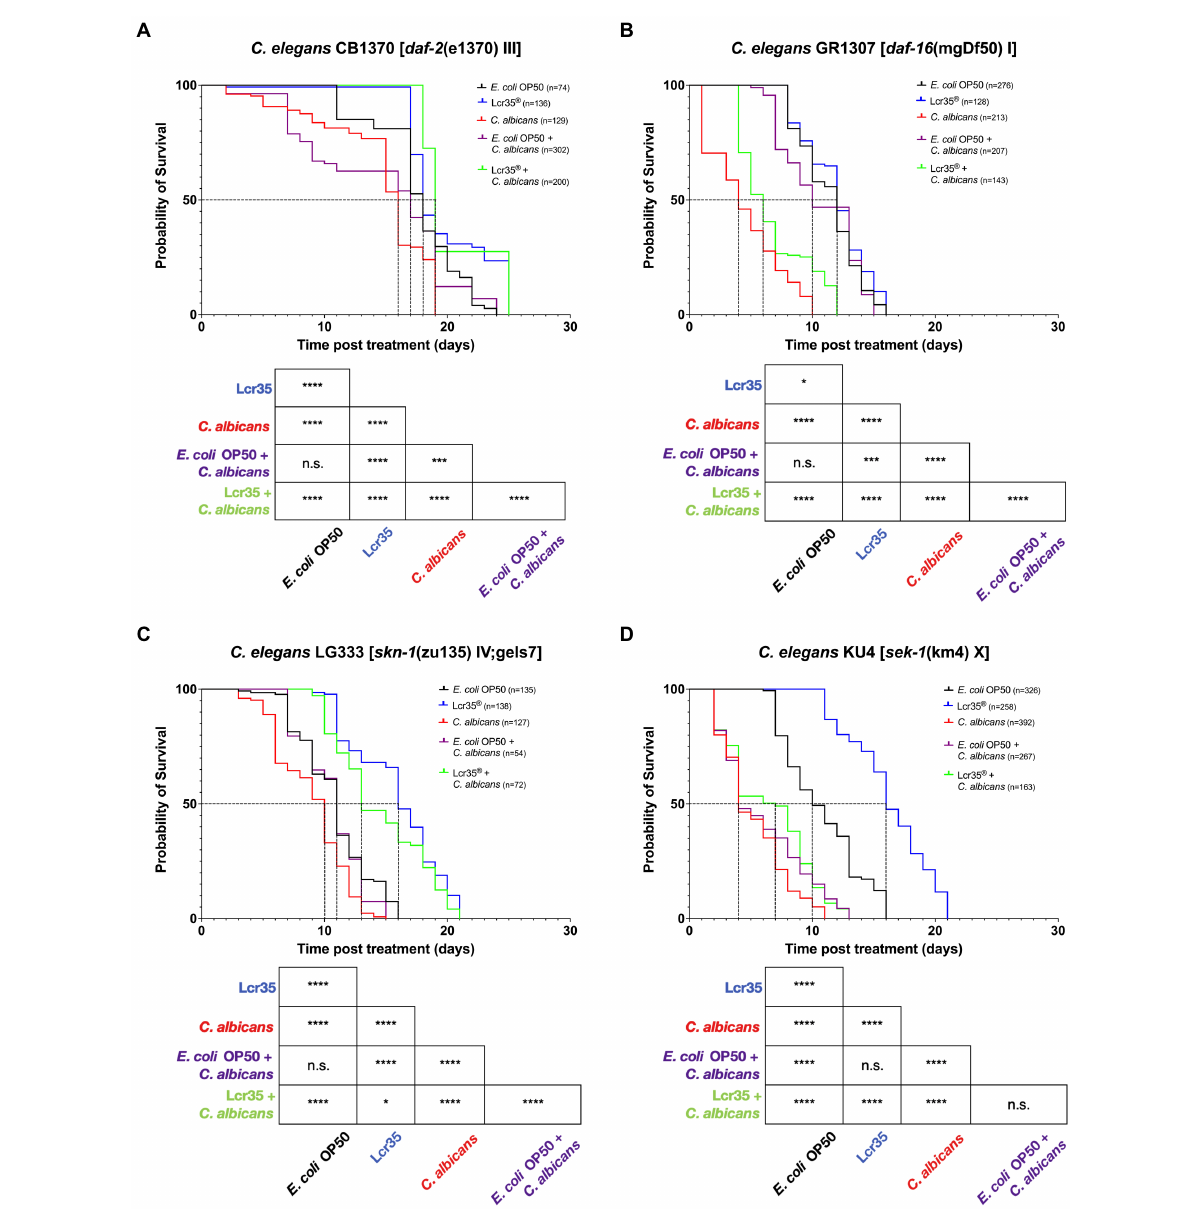
FIGURE 2 Preventive effects of Lcr35 ® against C. albicans in C. elegans daf-2 (CB1370) (A) , daf-16 (GR1307) (B) , sek-1 (KU4) (C) , and skn-1 (LG333) (D) loss- of-function mutant strains. The mean lifespan, where half of the population was dead, is represented on the abscissa. The asterisks indicate the value of p s (log-rank test) with E. coli OP50 as a control (NS, not significant; * p < 0.05; *** p < 0.001; **** p <